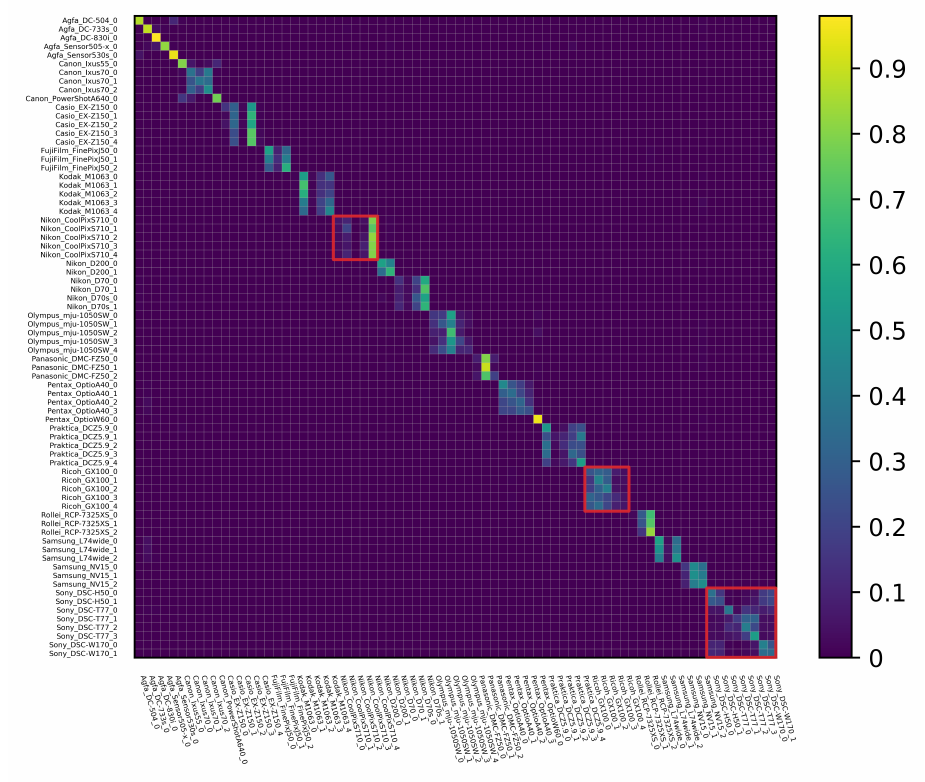
Figure 9. Confusion matrix of instance level